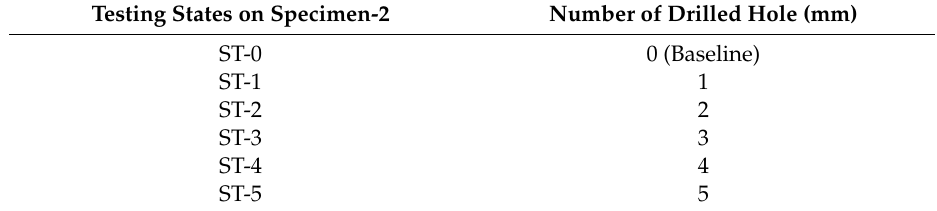
Table 3. Simulated multi-damage severity development by adding the drilled holes on specimen-2.